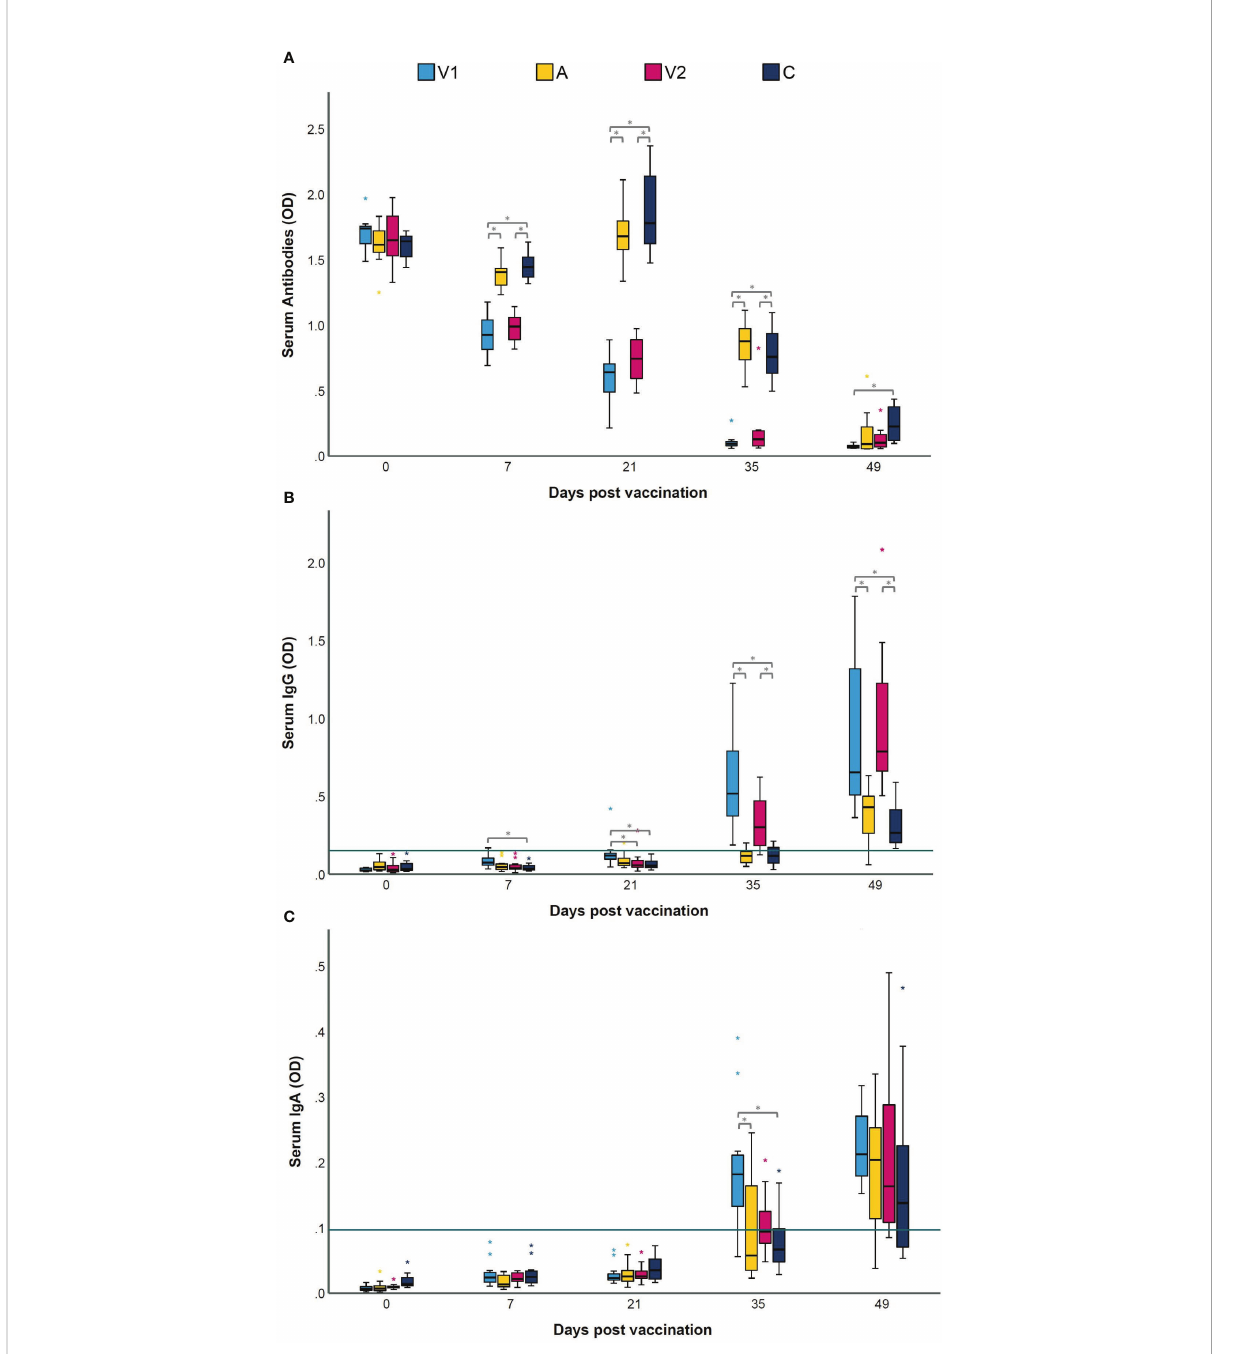
FIGURE 2 Serum antibody, IgG and IgA levels following vaccination and challenge infection. Piglets were vaccinated on D0 with V1, A, V2 or physiological saline solution (C), and animals were challenge infected on D21 and euthanized on D49. Serum antibody levels against Mycoplasma hyopneumoniae were measured with a commercial blocking ELISA (A) , and an indirect ELISA to determine IgG (B) and IgA (C) levels. In a blocking ELISA, a lower OD level corresponds with a higher antibody level. For M. hyopneumoniae -speci fi c IgG and IgA, serum samples were considered as positive if they had an average OD value higher than the cut-off value, which was calculated as the average OD of the serum samples of the sentinel group (S) + 3 times the standard deviation (SD) (green horizontal line). Values are expressed as optical density (OD). For each time point, signi fi cance was calculated using a Kruskal – Wallis H-test with Dunn-Bonferroni post hoc test. Statistical results were considered signi fi cant when p ≤ 0.05